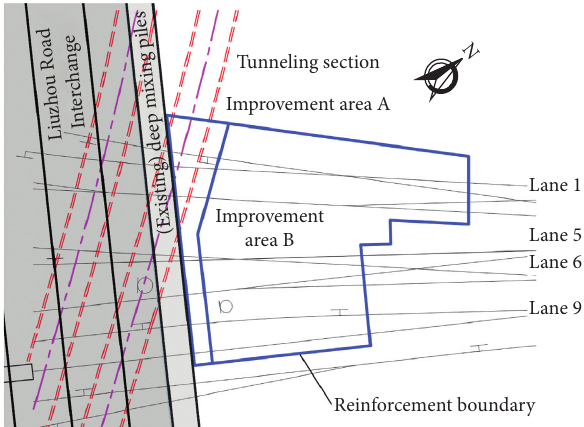
Figure 8: Plan view of the ground improvement areas.